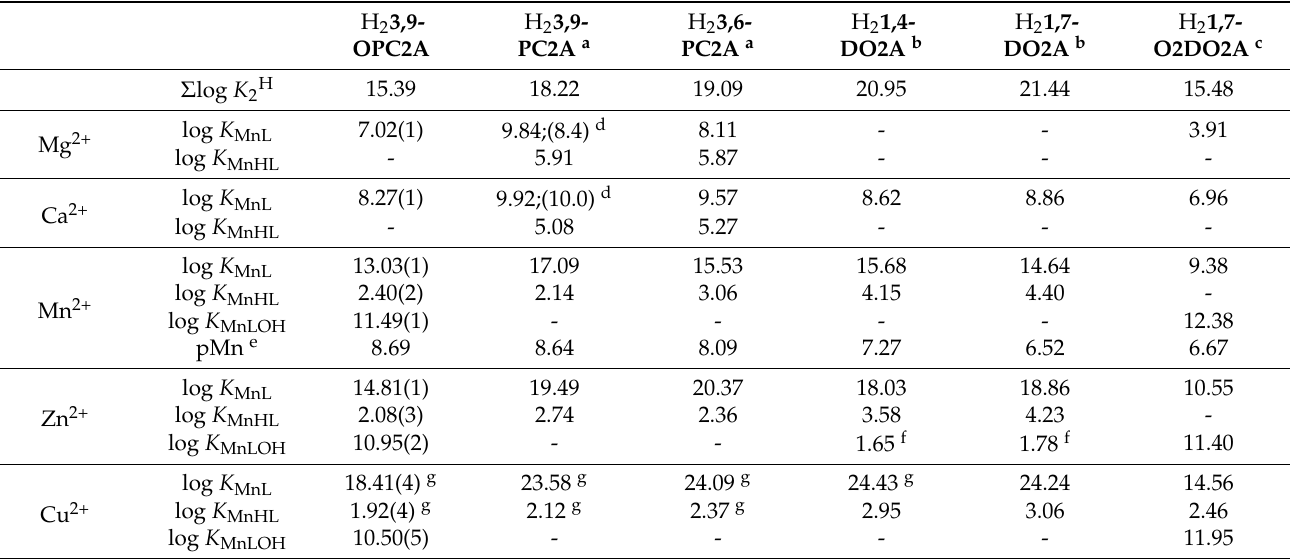
Table 3. Stability constants (log K ML ), protonation constants (log K MLHi ), and pMn values for the metal complexes formed with H 2 3,9-OPC2A , H 2 3,9-PC2A , H 2 3,6-PC2A , H 2 1,4-DO2A , H 2 1,7-DO2A , and H 2 1,7-O2DO2A ligands (T = 25 ◦ C, I = 0.15 M NaCl; the values shown in parenthesis are the standard